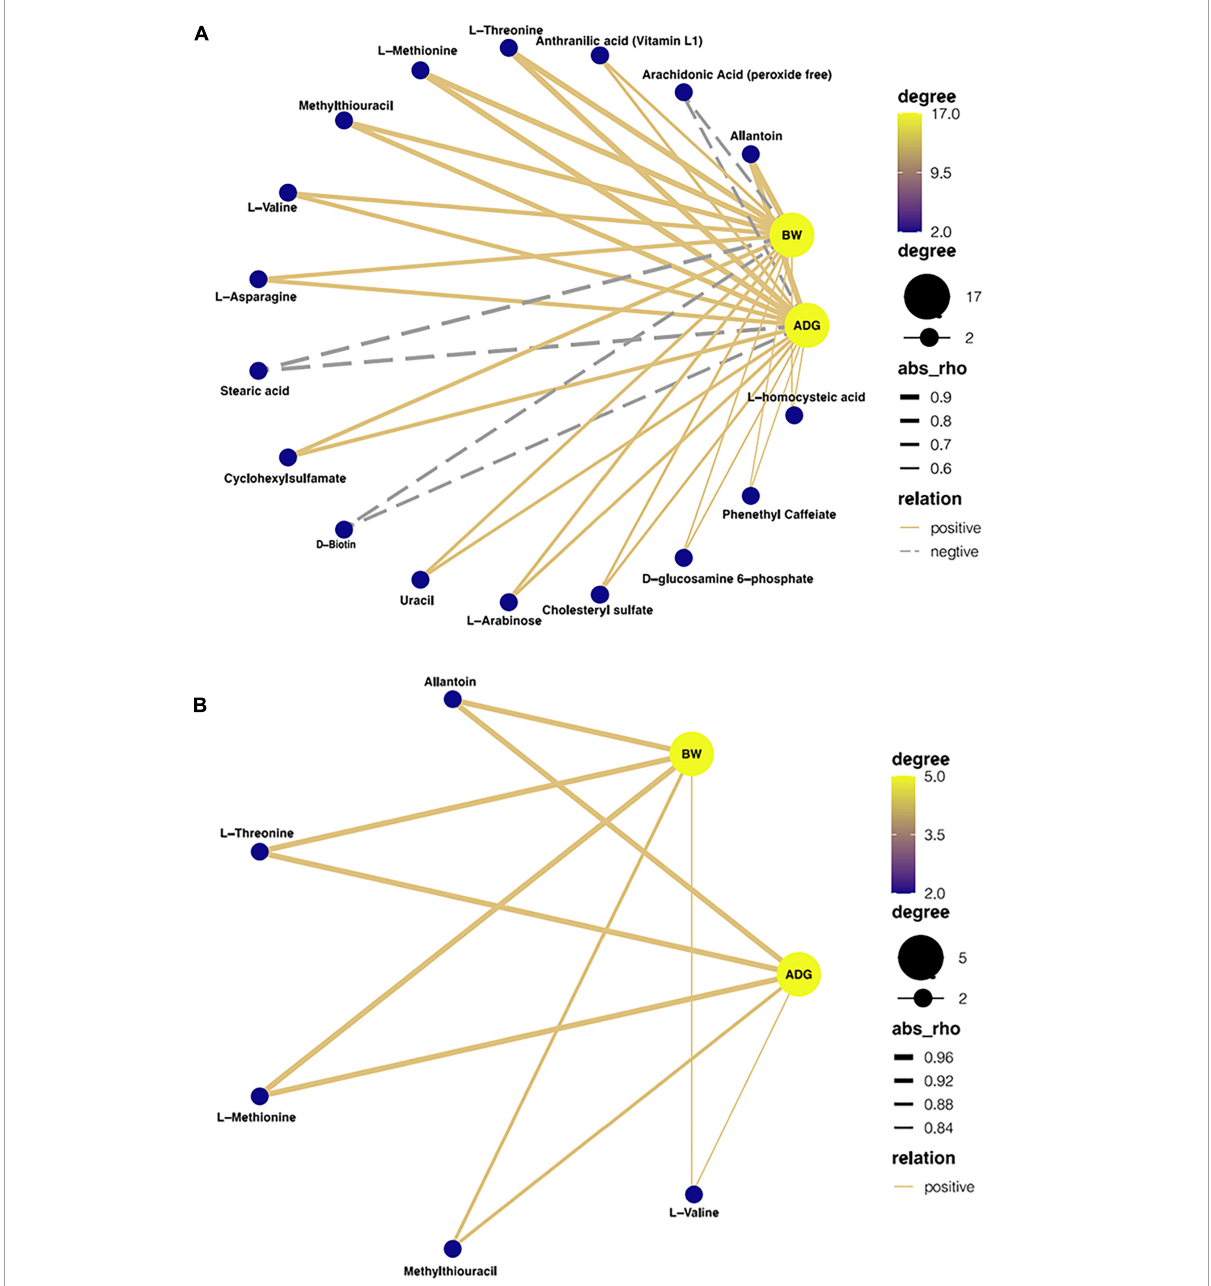
FIGURE7 Interaction network analysis between growth performance and metabolites in Ira rabbits. (A) 53 days old; (B) 67 days old. Blue nodes represent the center degree of genera and metabolites. The node size indicates the level of center degree. Lines linked to nodes indicate significant correlations among the species (FDR adjusted P < 0.05, | r| > 0.5), with orange and gray colors showing positive and negative correlations,